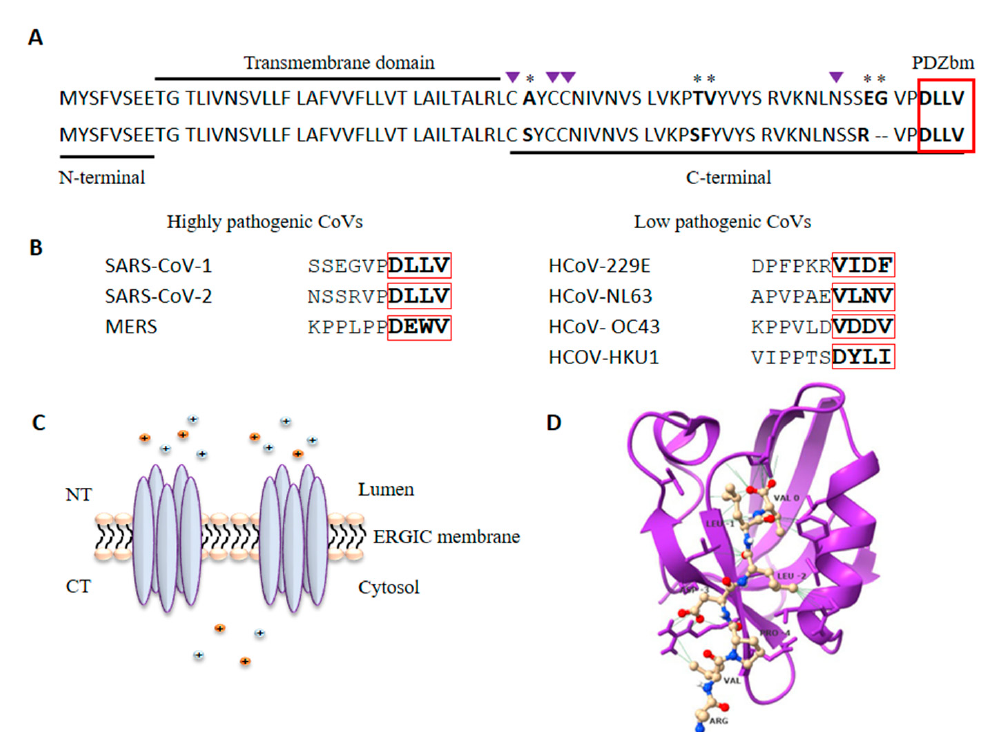
Figure 1. The E protein of SARS-CoV-1 and SARS-CoV-2 are 96% similar. ( A ) Alignment of the E protein sequence of SARS-CoV-1 (upper sequence) and SARS-CoV-2 (lower sequence); the three domains and the PDZbm (red box) are shown. * show amino acid differences and deletions between both proteins. Purple triangles indicate residues susceptible to posttranslational modification. ( B ) Alignment of the last ten amino acids of the highly pathogenic (left) and low pathogenic human CoVs showing the PDZbm. ( C ) Pentameric homo-oligomerization of the E protein forms an ion channel or viroporin. ( D ) Structure of the first PDZ domain of PALS1 in complex with the E protein of SARS-CoV-2 (PDB ID: 7NTK). Three-dimensional structure of PDZ1 domain of PALS1 (purple) in complex with the PDZbm of the E protein of SARS-CoV-2 (yellow); Figure is drawn with ChimeraX 1.2.5. (University of California at San